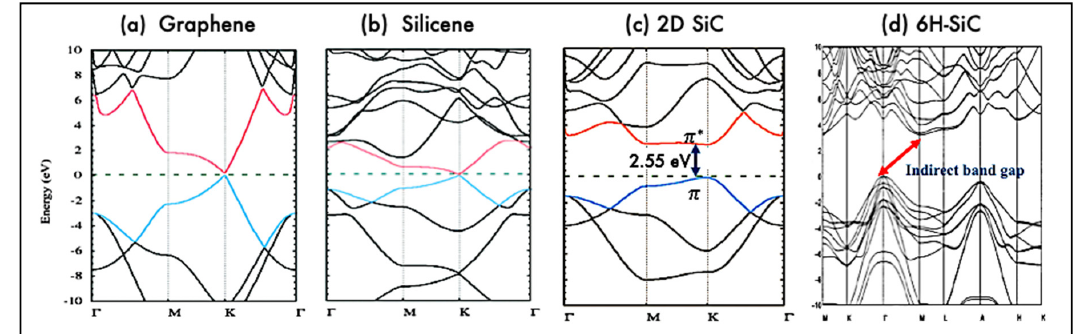
Figure 3. Electronic band structure of graphene, silicene, 2D SiC ( a – c ). Republished from [56] with permission from RSC. Electronic band structure of bulk 6H-SiC ( d ). Reproduced from [59] with